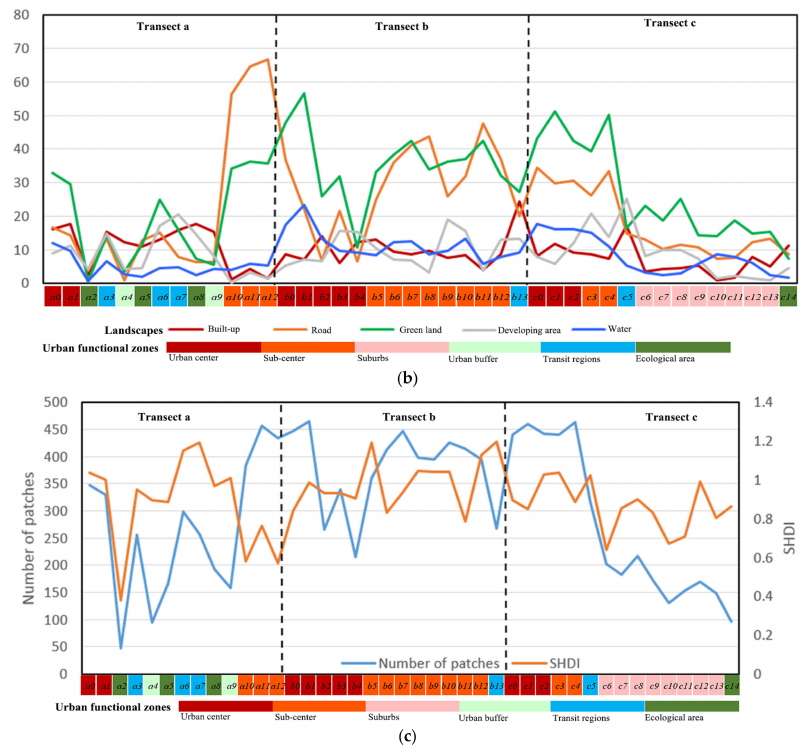
Figure 11. Patten of landscapes along urban gradient. ( a ) Class area; ( b ) patch density; ( c ) number of patches and Shannon’s diversity index